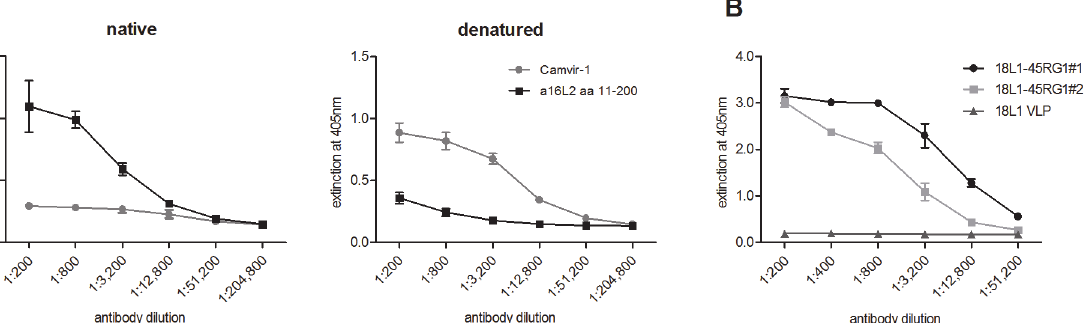
Fig 4. ELISA to characterize VLP surface-display of RG1-peptide and to detect antibodies to RG1 induced by 18L1 – 45RG1 VLP vaccination. (A) Native or denatured HPV18L1 – 45RG1 VLP were attached to 96-well ELISA plate and contacted with serial dilutions of anti-HPV16 L2 polyclonal serum recognizing the RG1 epitope. The anti-L2 serum recognized both native and denatured chimeric VLP, indicating RG1 display on the surface of VLP. As a control, binding of mAb Camvir-1 was assessed, which is directed to a linear L1 epitope hidden in the assembled protein. (B) Biotinylated peptides representing HPV45 RG1 were attached to 96-well Streptavidin plates. ELISA was performed in triplicates using either immune sera raised to HPV18L1 – 45RG1 VLP or HPV18L1 VLP, or pre-immune sera, with dilutions ranging from 1:200 to 1:51,200. HPV18L1 – 45RG1 immune sera, but not HPV18L1 VLP sera or pre-immune sera, bound to the RG1 peptide at titers of 12,800 to 51,200 (serum #2 and #1, respectively). Data are shown as mean OD ± standard deviation (SD) and titers reported as mean values 3 SD above background signals (pre-immune values).